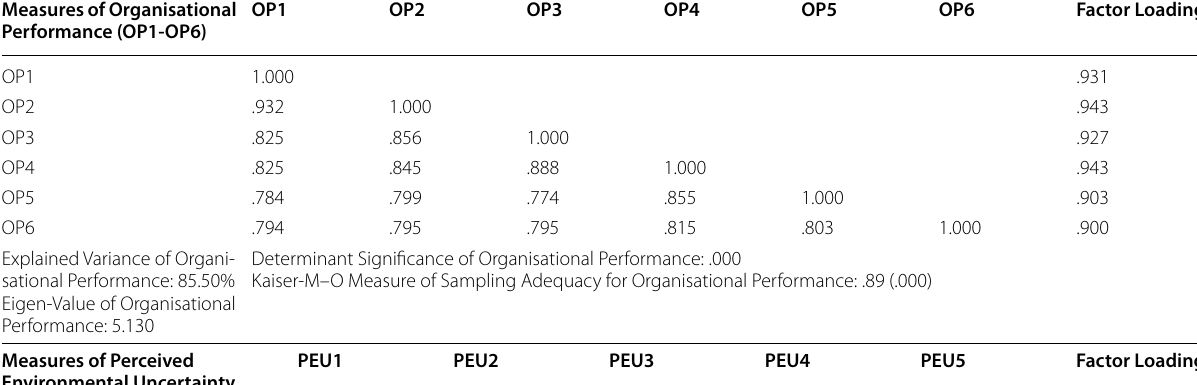
Table 4 Summary of Principal Component Analysis & Item Inter-Correlation Analysis for Organisational Performance, Perceived Environmental Uncertainty, and Competition Intensity ( n Measures of Organisational Performance (OP1-OP6)